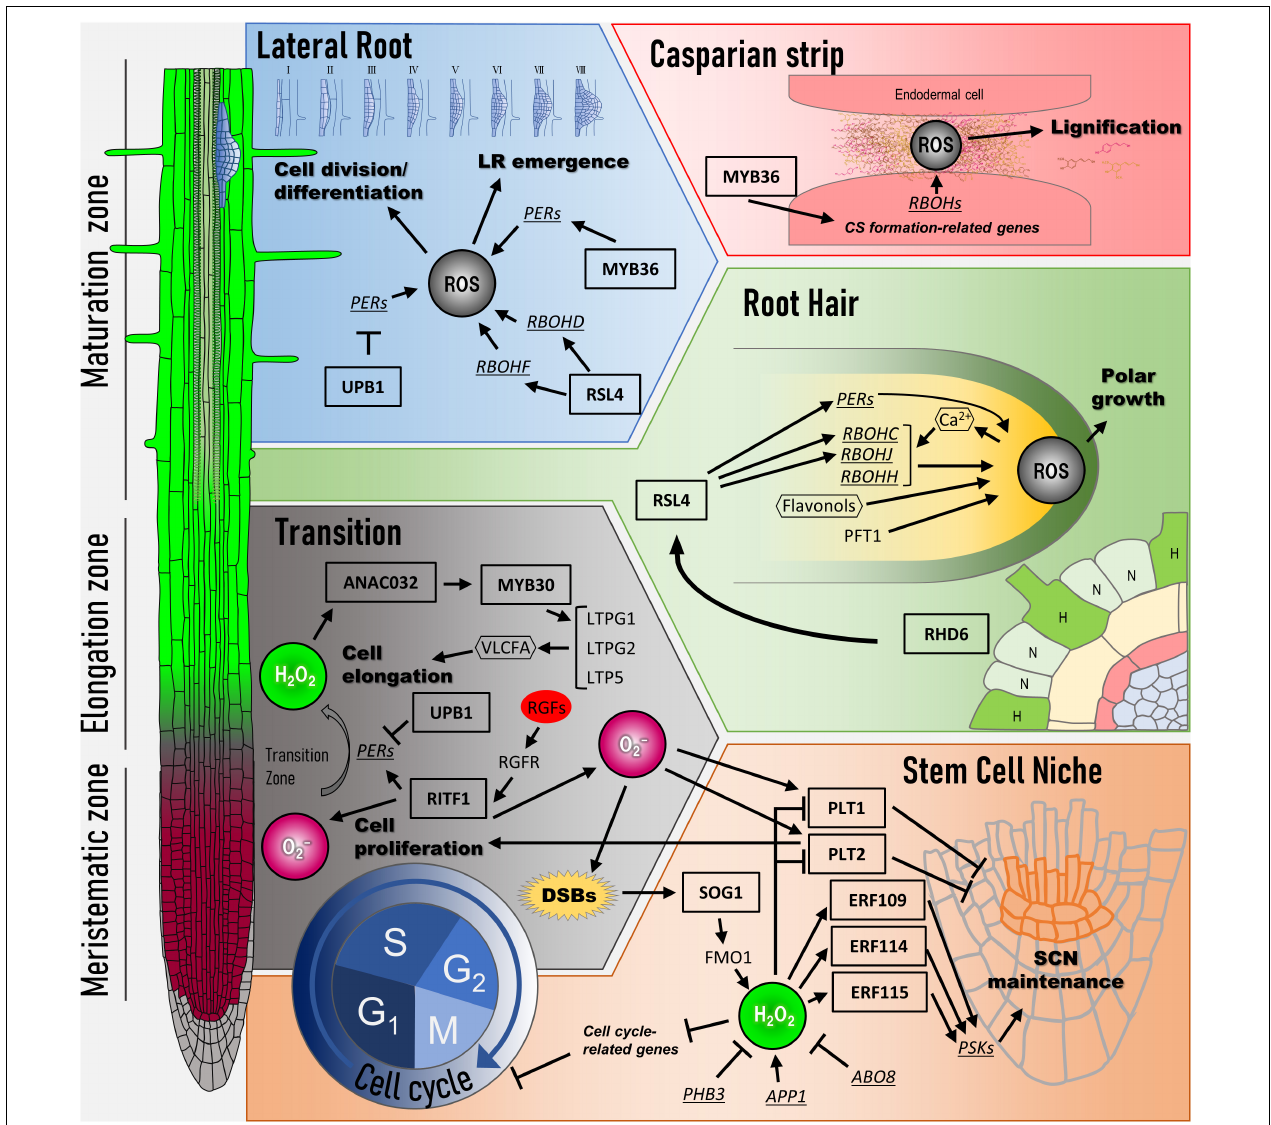
FIGURE 1 | Transcriptional network of ROS signaling for root development. At the left side, three regions in Arabidopsis root are shown (meristematic zone, elongation zone, and maturation zone). Color gradient in the primary root indicates the distribution of ROS (red: O 2 – and green: H 2 O 2 ). Cell cycle: ROS regulates the expression of G 1 –S as well as G 2 –M transition-related genes. SOG1, a key transcription factor, is activated in response to DNA damage such as double-strand breaks (DSBs). SOG1 directly induces the expression of FMO1, which encodes flavin-containing monooxygenase. H 2 O 2 level modulated by FMO1 influences the expressions of cell cycle-related genes. Stem cell niche: H 2 O 2 level is lowered by ABO8, PHB, and RITF1 signaling pathways, whereas APP1 signaling pathway leads to its accumulation. H 2 O 2 regulates the expression of ERF109 , ERF114 , and ERF115 and represses PLT activity for SCN maintenance. RITF1 signaling pathway positively regulates PLT activity through O 2 – accumulation. Transition: ROS spatial distribution between O 2 – and H 2 O 2 decides the transition from cell proliferation to cell elongation. UPB1, a key transcription factor, changes ROS spatial distribution by regulating the expression of peroxidases (PERs). RITF1 also controls the meristem size under ROS signaling through PLT2 protein stability. In the elongation zone, ANAC032 and MYB30 regulate the expression of cell elongation-related genes in response to H 2 O 2 . Root hair: Whether epidermal cells can form root hair is determined by gene network (H, hair cells; N, non-hair cells). The RHD6 gene regulatory network begins to bulge at the root hair initiation site in H cells. RSL4, which is under the RHD6 gene regulatory network, controls the expression of RBOHC / RHD2 , RBOHJ , and several PERs for the root tip growth. A positive feedback loop is formed during hair elongation among Ca 2 + -permeable channels and RBOHs via ROS. In addition, ROS distribution in the root hair tip is controlled by PFT1, which regulates the expression of PERs . Flavonols contribute to the development of root hair as antioxidants, which modulate ROS accumulation. Lateral root: Lateral root (LR) development is initiated from pericycle cells called founder cells. UPB1 controls LR emergence by regulating the expression of PERs at the peripheral cells of LRP. RSL4 regulates the expression of RBOHs , followed by ROS production, for facilitating LR emergence. MYB36 in LR development maintains ROS balance at the LRP boundary in the pericycle cells to allow their transition from flat to dome-shaped primordia. Casparian strip: In the endodermal cells, localized ROS in apoplasts induced by RBOHD and RBOHF are utilized for the lignification for the Casparian strip formation. Arrows indicate positive regulation, and blunted lines indicate negative regulation. Ovals, rectangles, and hexagons indicate signal molecules such as plant hormones, transcription factors, and secondary messenger molecules, respectively. PER, peroxidases; DSB, double-strand breaks; SCN, stem cell niche; LR, lateral root; CS, Casparian strip.